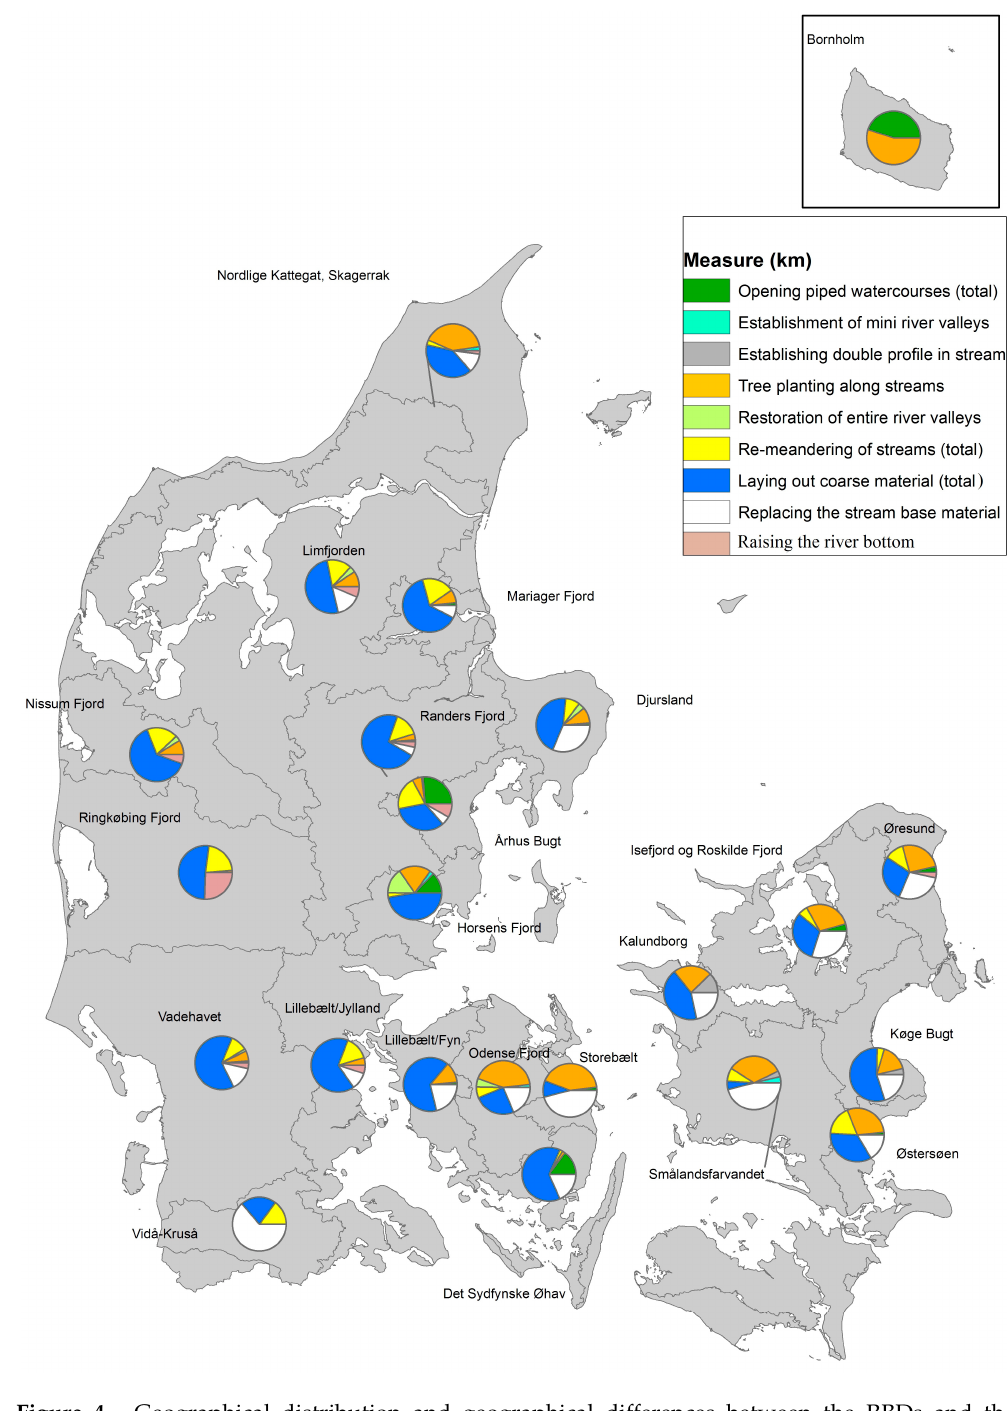
Figure 4. Geographical distribution and geographical differences between the RBDs and the chosen measures.